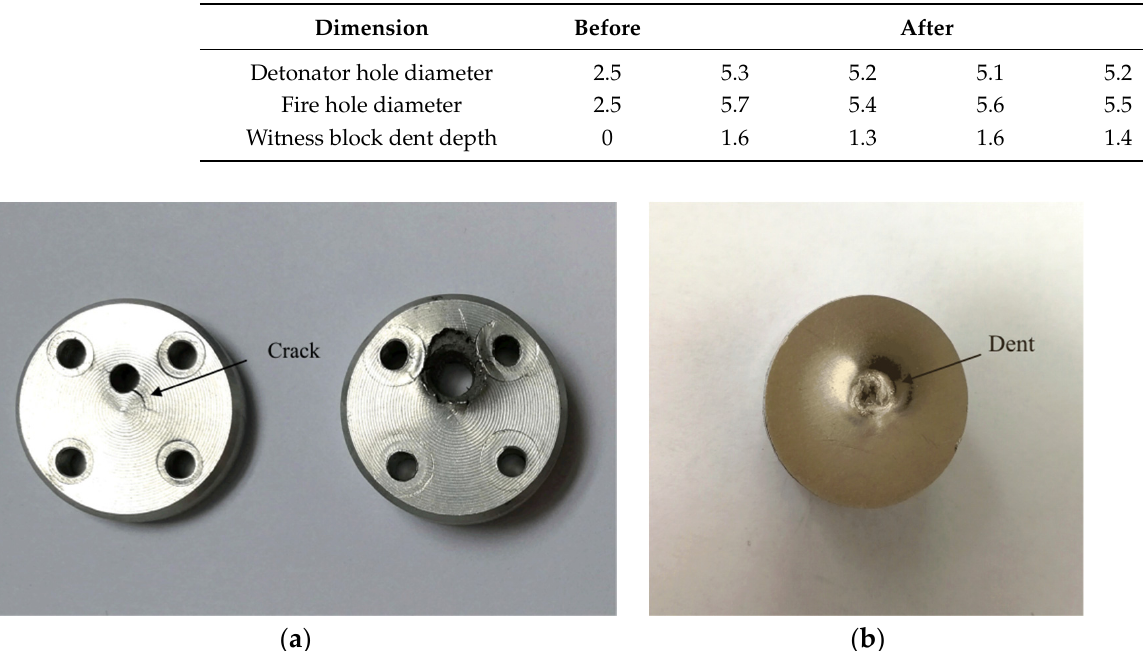
Figure 33. Residual body. ( a ) Upper cover and base; ( b ) Witness block. Table 7. Dimensions before and after the tests (mm).